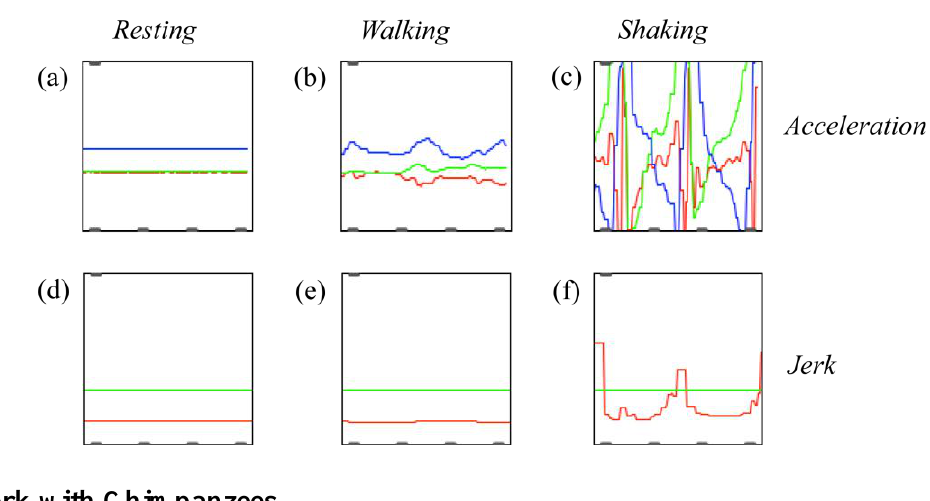
Figure 7. Acceleration readings (top row) from the wireless prototype and computed jerk values (bottom row) under three different conditions